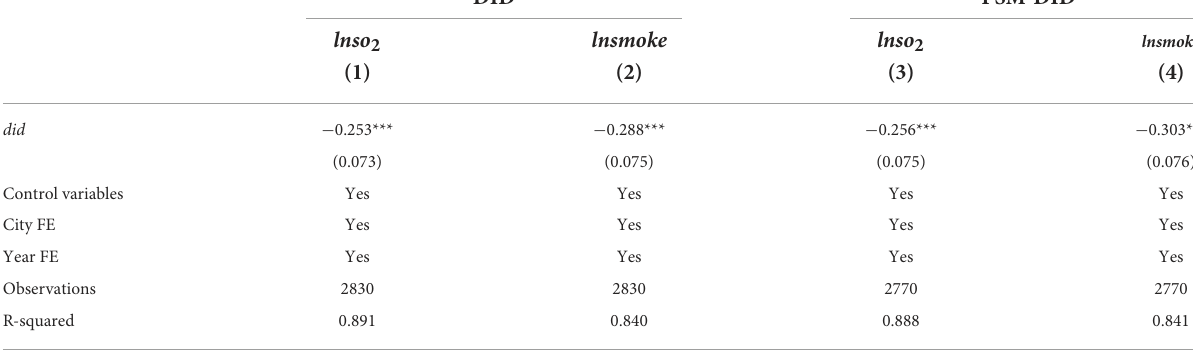
TABLE 2 Effects of environmental tax reform on urban air